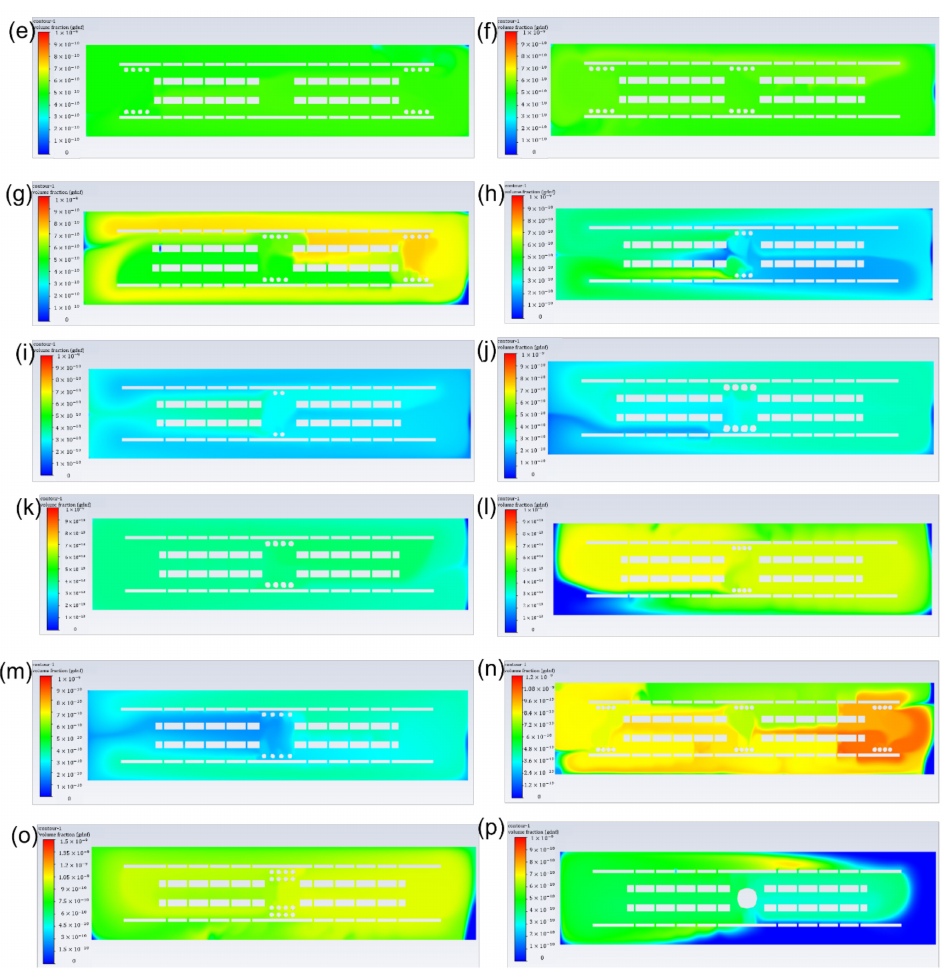
Figure 4. GDNF distribution of different drug release systems under the assumption of constant simu- lation time. ( a ) Single-layer microsphere system (microsphere features: quantity: 8; diameter: 0.1